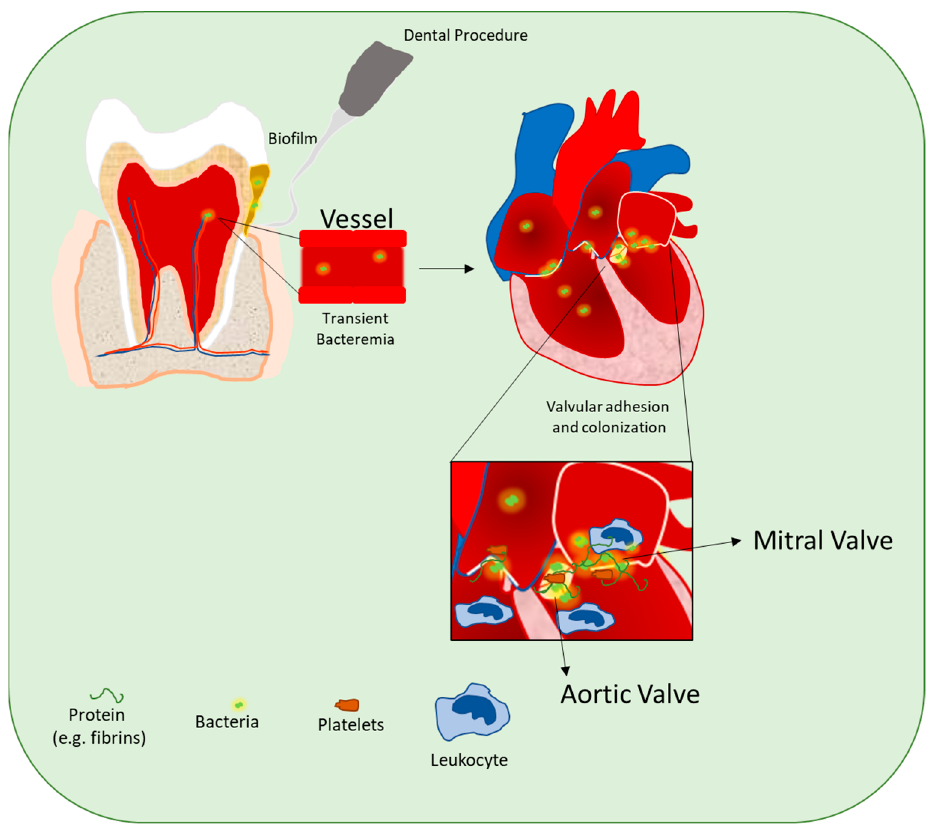
Figure 2. Schematic representation of different stages of endocarditis development after dental procedures.